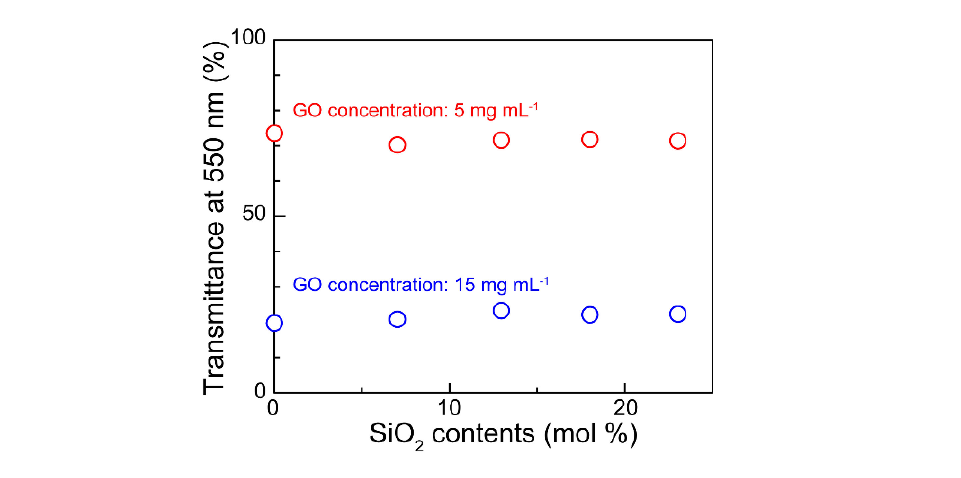
Figure 16. Transmittances of trGO/SiO 2 films at 550 nm plotted against silica contents for GO = 5 mg mL − 1 (red) and 15 mg mL − 1 (blue).